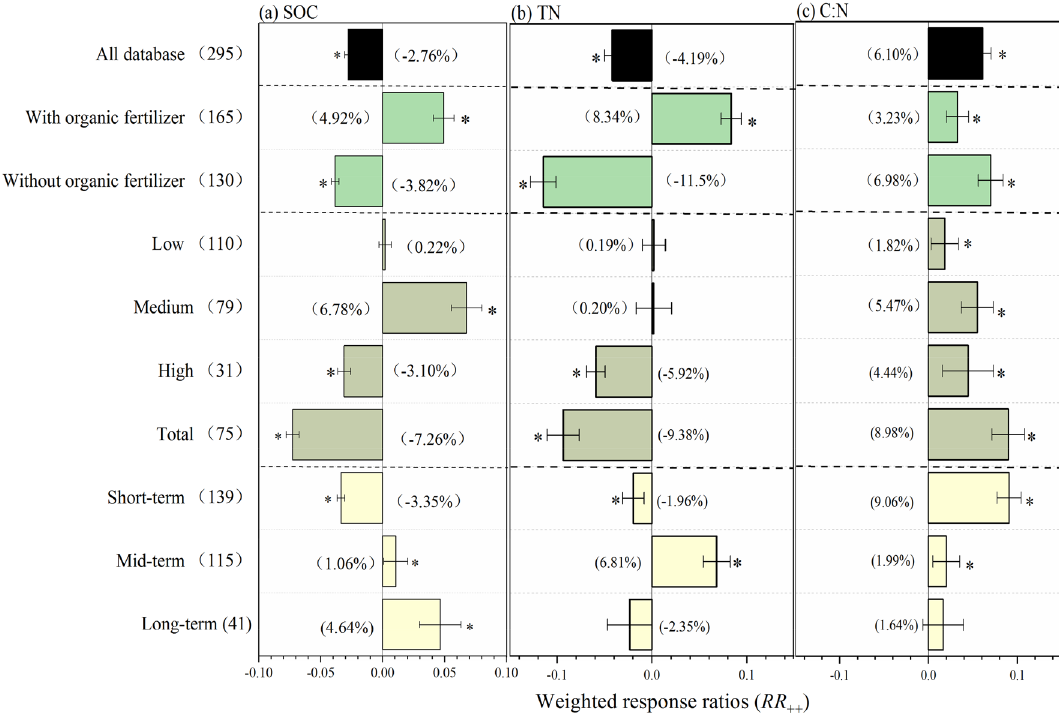
Figure 1. The weighted response ratio ( RR ++ ) for the responses to chemical nitrogen fertilizers of soil organic carbon (SOC, a ), total nitrogen (TN, b ), and their ratios (C:N, c ). Bars denote the overall mean response ratio RR ++ and 95% confidence intervals (CI). The star (*) indicates significance when the 95% CI that do not go across the zero line. The vertical lines are drawn at ln RR = 0. The value represents independent sample